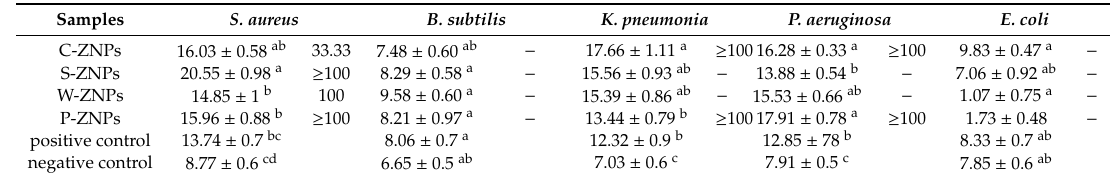
Table 1. Zones of inhibition (expressed in mm) and minimum inhibitory concentrations (MICs) (expressed in µg/mL) of the synthesized NPs against various bacterial strains. Samples S. aureus B.